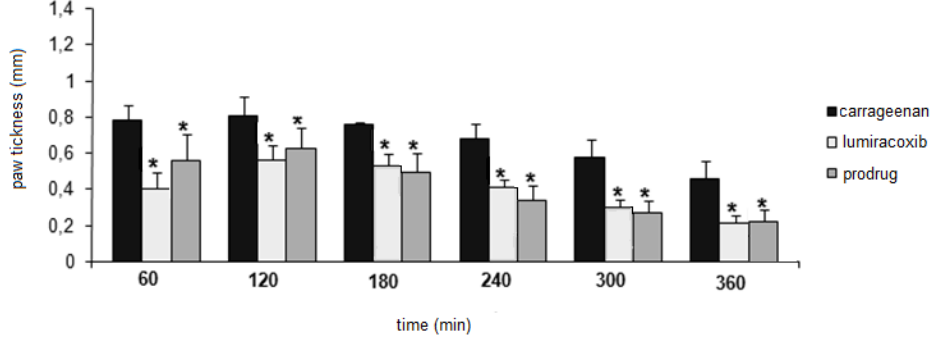
Figure 1. Anti-inflammatory activity in carrageenan-induced paw edema in rats (data are represented as mean ± S.E.M., n = 6, * P < 0.05 related to carrageenan group; dose of compounds = 300 μ mol/kg).